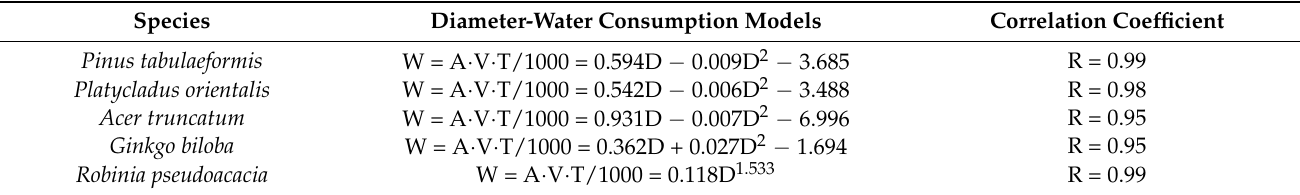
Table 1. Diameter-water consumption models of trees.